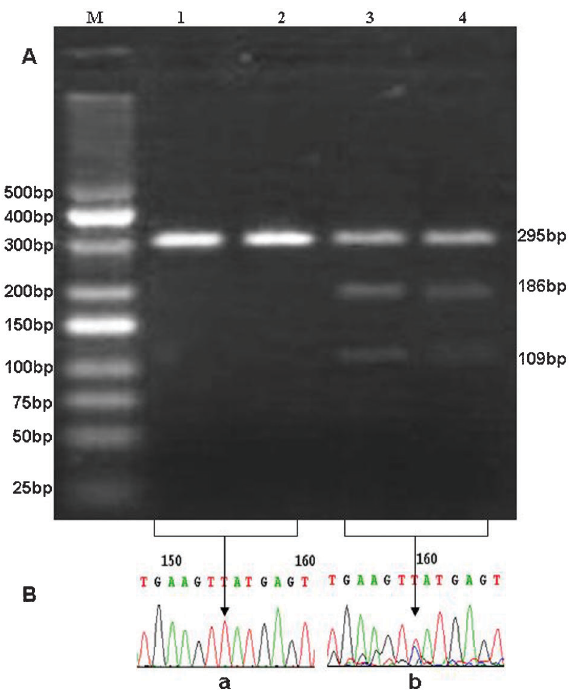
Figure 1. Genotypes of the ELOVL6 single nucleotide poly- morphism (SNP) rs12504538. A , Restriction fragment length polymorphism analyses for determination of the rs12504538 genotype (digested by Rca I). The TT genotype shows a band of 295 bp ( lanes 1 and 2 ) and the CT genotype shows 3 bands of 295, 186, and 109 bp ( lanes 3 and 4 ). B , Nucleotide sequences surrounding the SNP rs12504538. a , TT genotype; b , CT genotype. Lane M : DNA